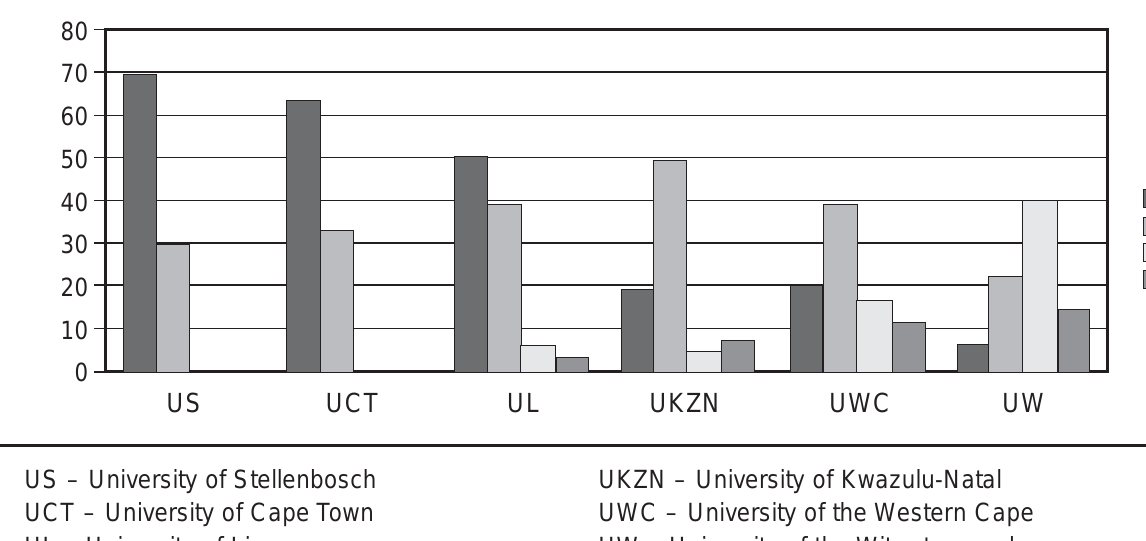
Figure 1: Frequency of ICT use at university